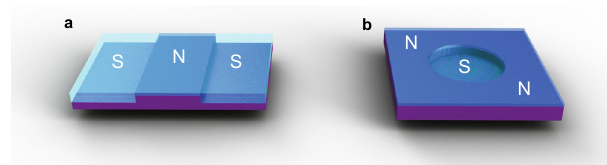
Fig. 4 Topological mesoscopic super fl uidity, where con fi nement tunes 3 He into different material phases, enabling hybrid structures. a An SNS junction, where spatial modulation of cavity height de fi nes SN interfaces. b Circular region of higher cavity height de fi nes an isolated mesa of super fl uid, cooled through normal liquid in a more con fi ned region. Purple plates represent the silicon wafer, darker blue regions normal liquid 3 He, and lighter more transparent regions super fl uid 3